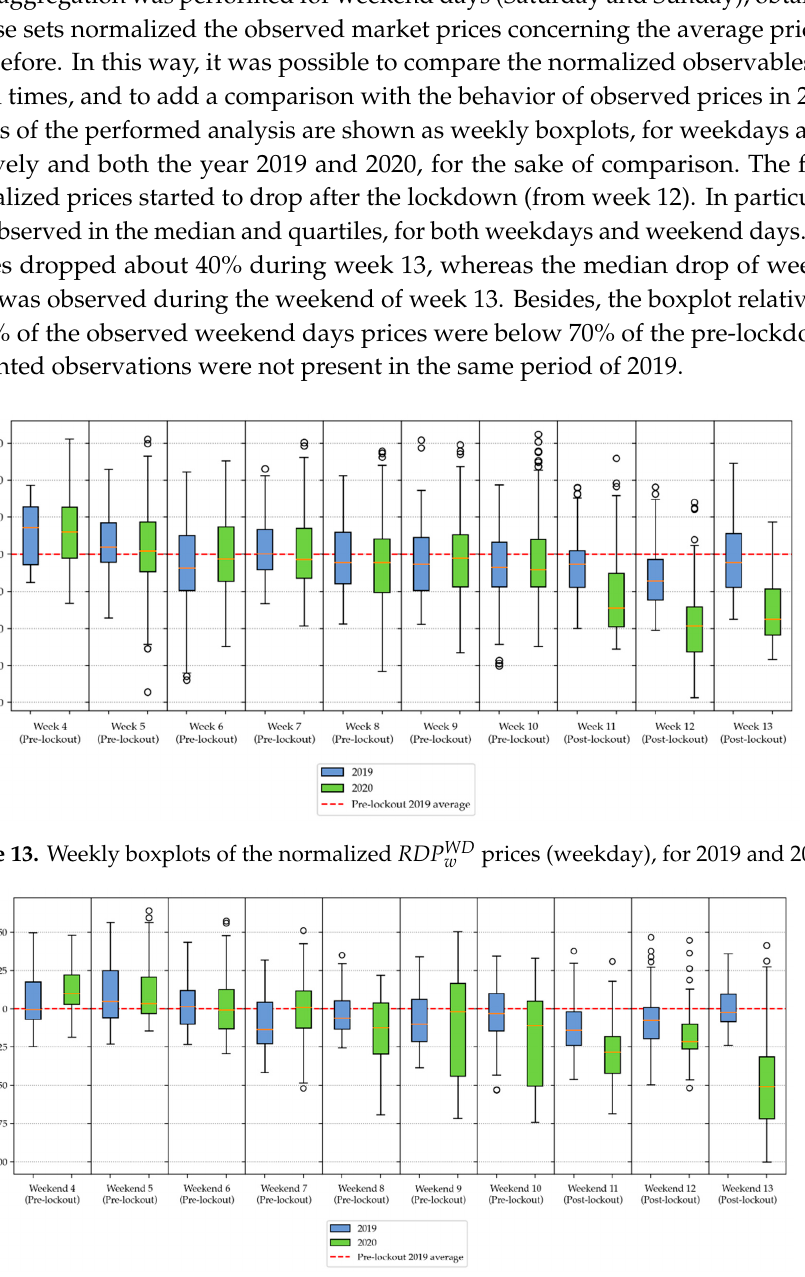
Figure 14. Weekly boxplots of the normalized (cid:1844)(cid:1830)(cid:1842) (cid:3050)(cid:3024)(cid:3006) prices (weekend days), for 2019 and 2020.